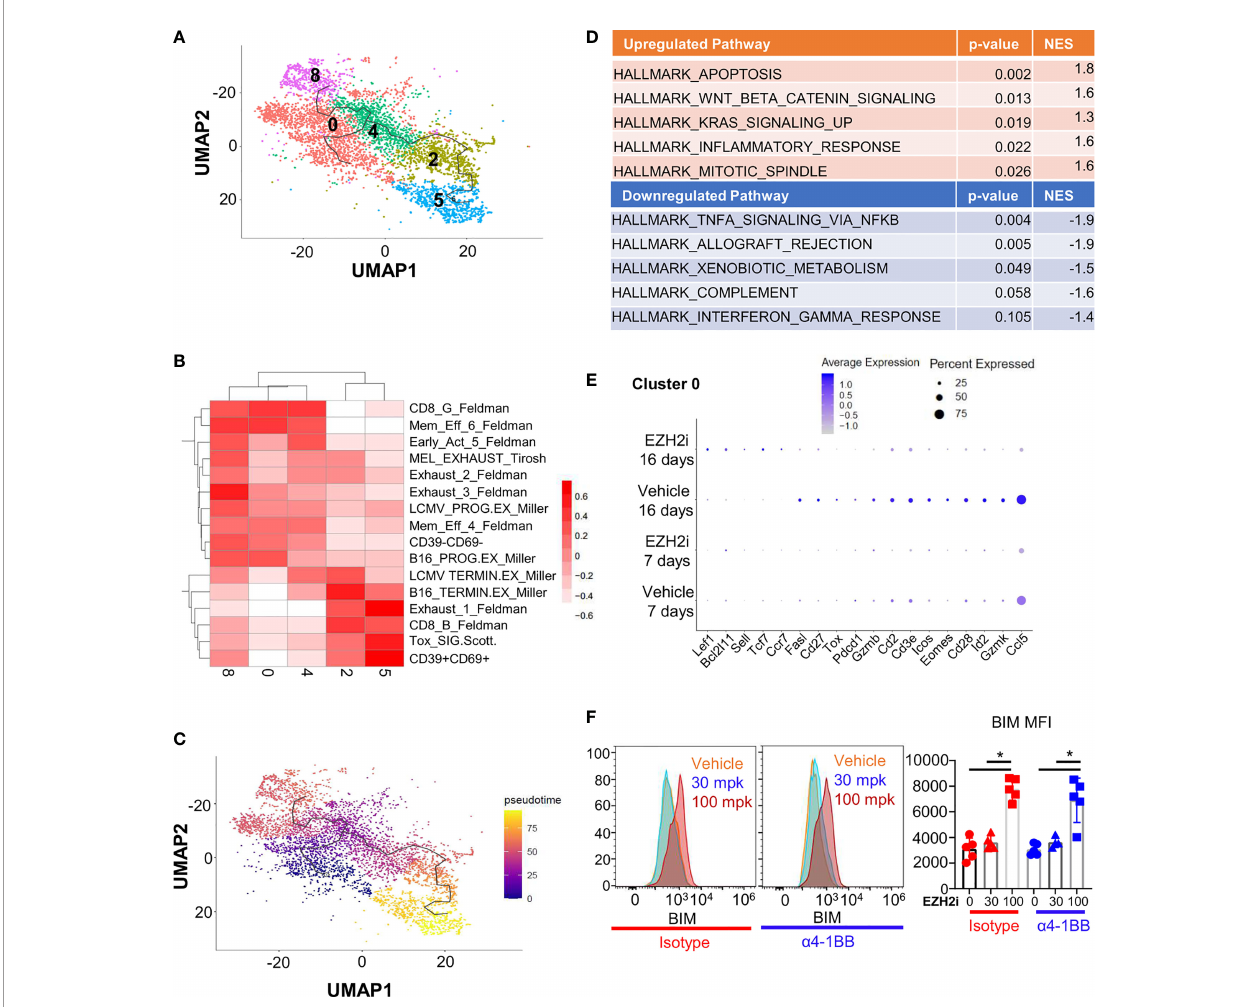
FIGURE 3 | EZH2i impact the transcriptional effector program and pro-apoptotic protein expression. MC38 tumor cells were implanted in naïve mice and treated for 16 or 7 days prior to takedown with 100 mpk EZH2i. CD45 + T cells were isolated and scRNA-Seq performed with subsequent lymphocyte reclustering and focusing on CD8 + clusters (A) . GSVA heatmap depicting CD8 + clusters aligned to publicly available CD8 + populations found in exhaustion models (B) . Monocle analysis was performed to determined trajectory of differentiation within CD8 + clusters in pseudotime (C) . Pathways most impacted in CD8 + T cells by EZH2i treatment were determined by comparing DEG lists to Hallmark molecular signatures database. The top 5 up- and downregulated pathways are shown (D) and the complete lists can be found in Tables S2 , S3 . Dot plot of curated DEG of interest from the cluster with the most DEG (Cluster 0) are depicted (E) . BIM levels were determined in vivo at day 5 post OVA immunization (from Figure 2 ) (F) . Representative histograms ( F , left two panels) and pooled data ( F , right) were determined by intracellular fl ow cytometry. Mice treated with isotype are marked in red; mice treated with a 4-1BB are marked in blue. Vehicle treated control mice are marked with circles; triangles indicate 30 mpk EZH2i treatment while squares indicate 100 mpk EZH2i treatment. NES indicates normalized enrichment score. Asterisks (*) indicate p<0.05 as determined by 2way ANOVA and post hoc comparison of group